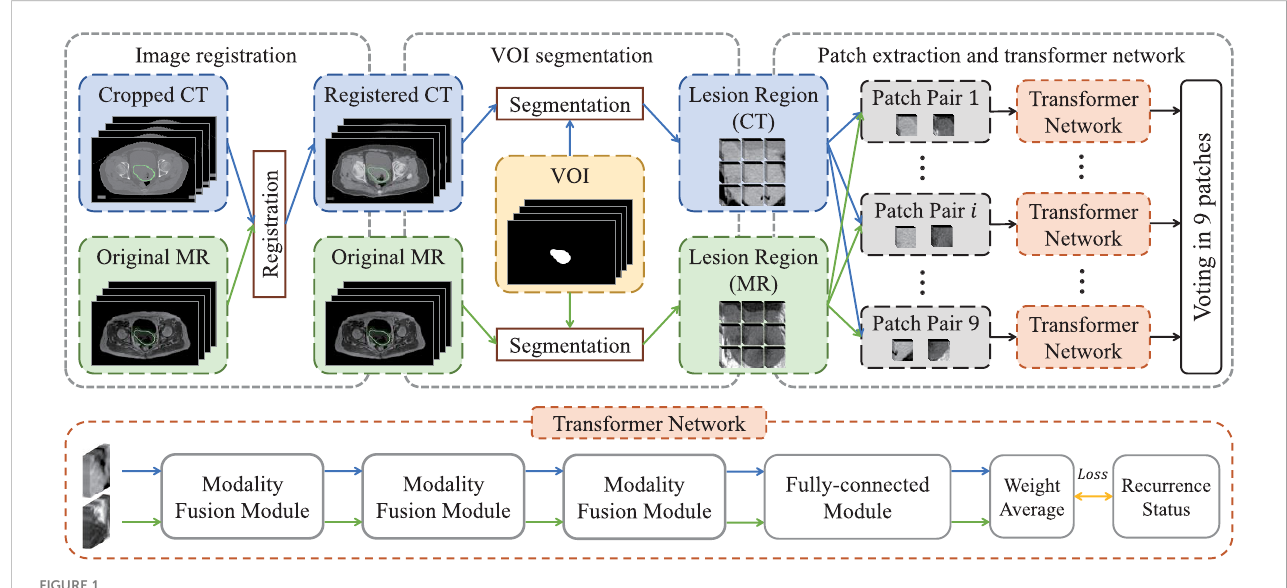
FIGURE 1 The fl ow chart of the proposed model for the recurrence risk strati fi cation of